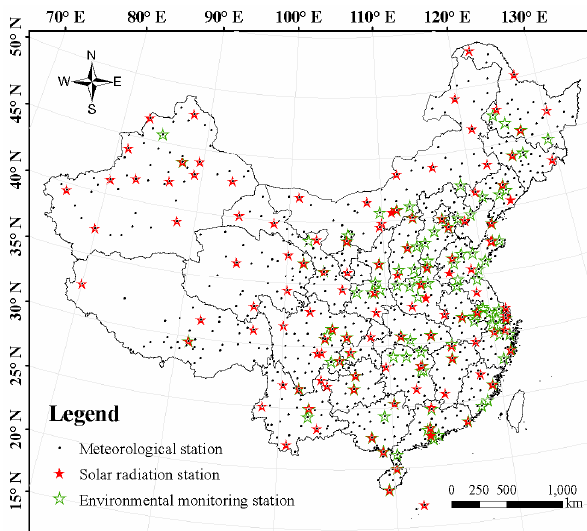
Fig. 1. Geographical locations of the 756 meteorological stations, 122 solar radiation stations and 120 environmental monitoring stations in China.